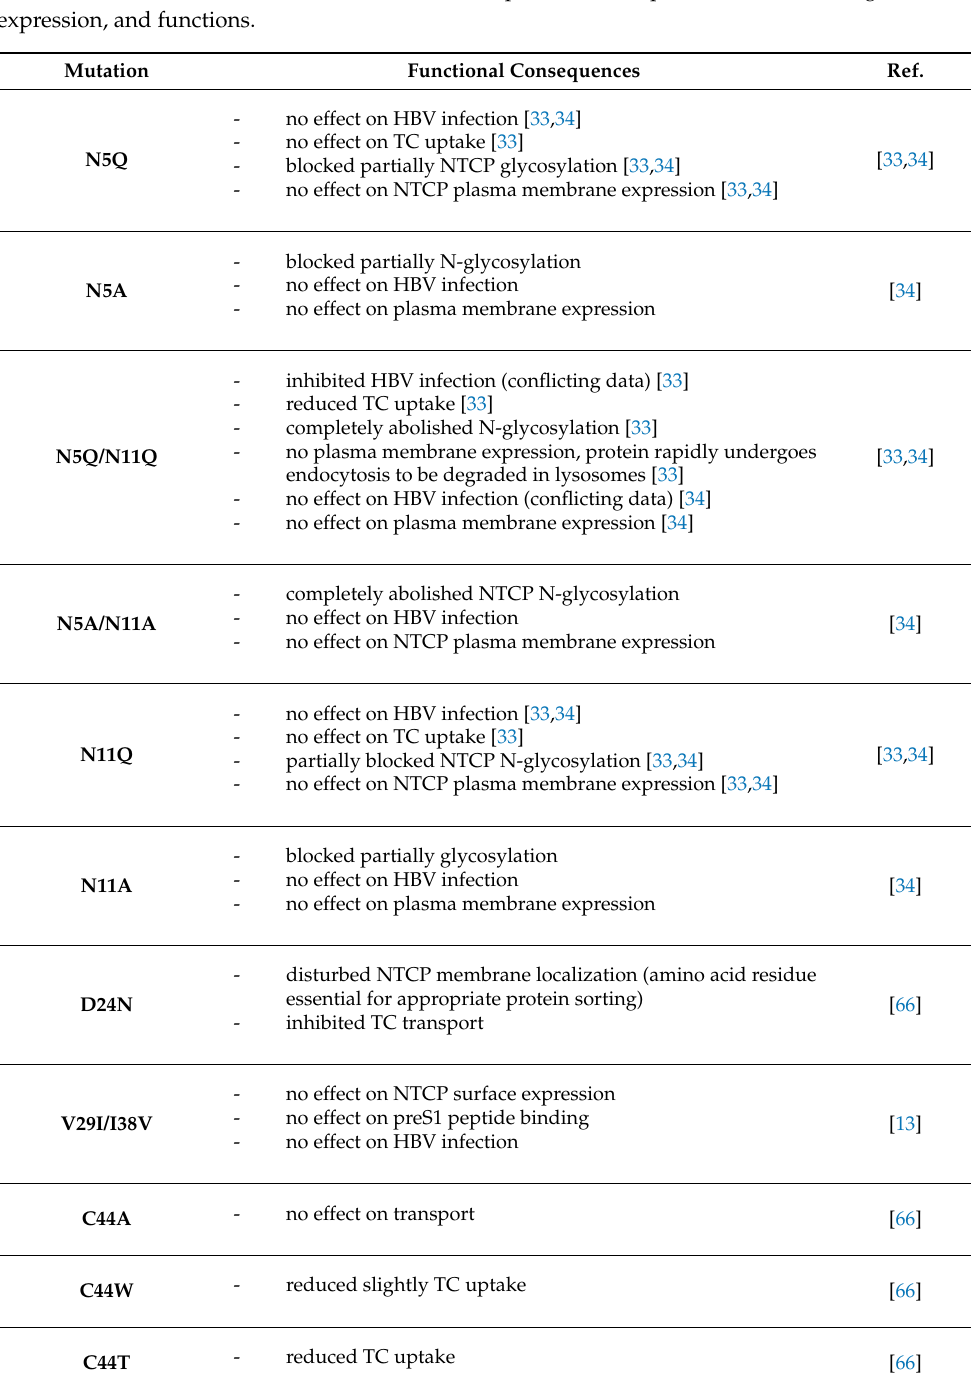
Table 1. Mutations in human NTCP and rodent Ntcps that were reported to affect folding, structure, expression, and